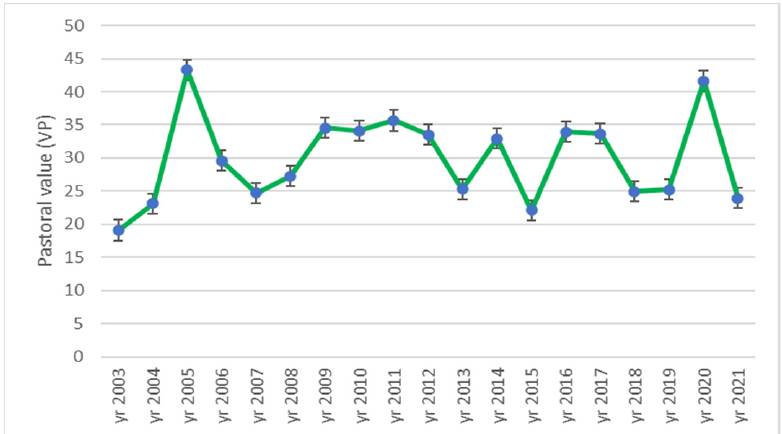
Figure 9. Dynamics of pastoral value (PV) during 2003–2021 period in ex-arable grassland from Gr ă dinari (standard error displayed).